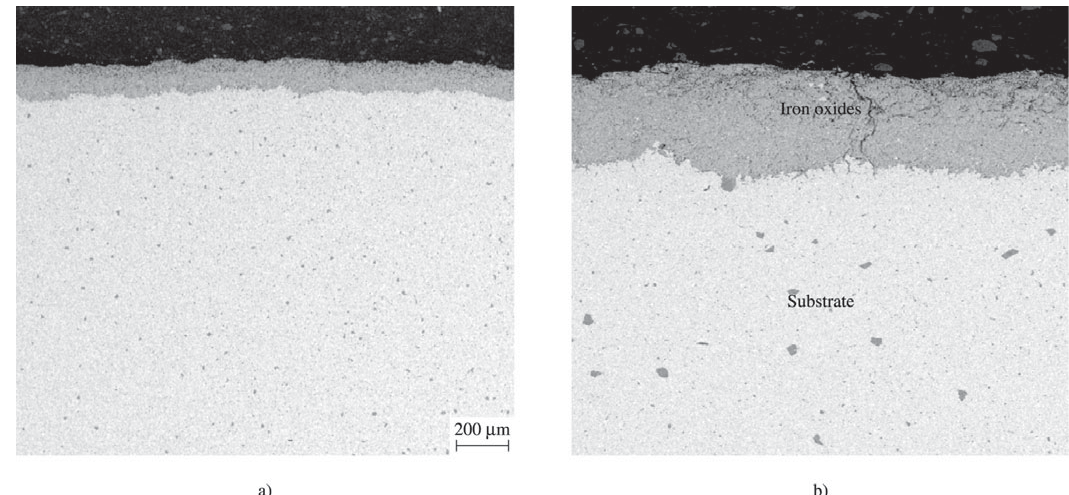
Figure 3. SEM cross-section of the G11 steel sample subjected to the real condition at 650 °C, with different magnifications. a) General view of the corroded layer and substrate; b) Expanded view of the corroded layer/substrate interface, showing in details the fissure in the corroded layer and the presence of precipitates in the substrate.